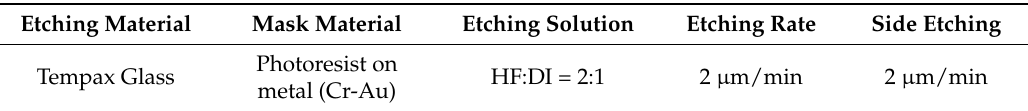
Table 3. Wet etching